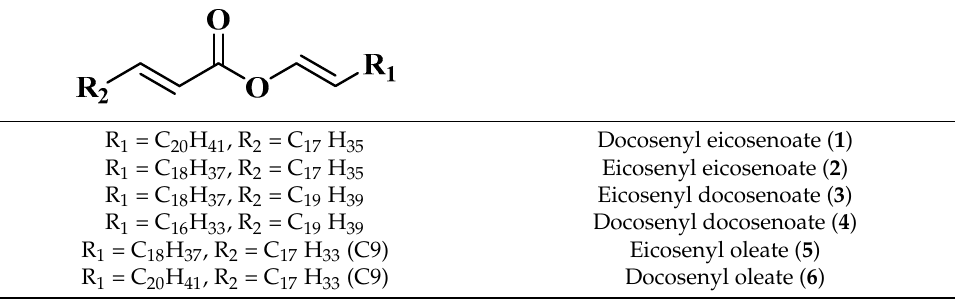
Table 1. Chemical structures for the most abundant wax ester components in jojoba wax.